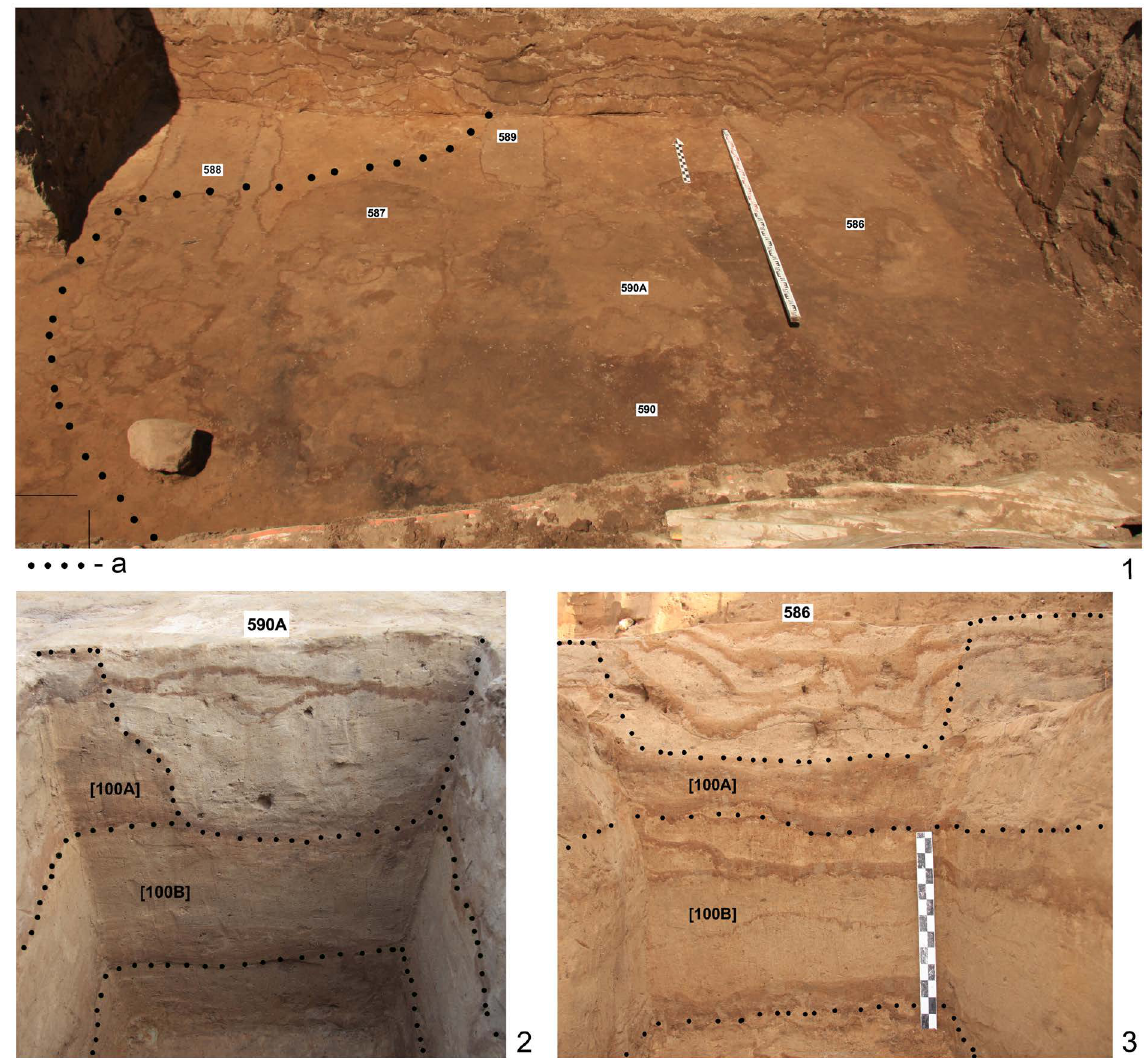
Figure 6. Weklice, Elbląg County. 1 . level of detection of graves and features in the exposed area of the trench; a. conjectured boundary of the occupation layer [100A]; 2. cross-section of feature 590A with visible layers [100A] and [100B]; 3. cross-section of grave 586 with visible layers [100A] and [100B]. (Photo by G. Czopowicz and M. Natuniewicz- Sekuła.